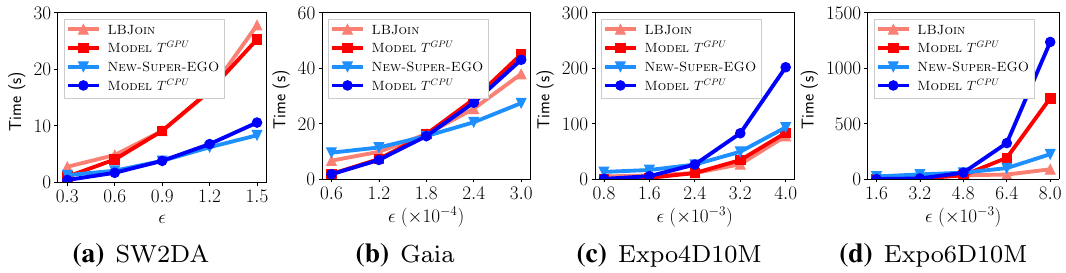
Fig. 8 Comparison of the modeled execution times T GPU and T CPU vs. their corresponding reference execution times LBJ oin and n Ew -S upEr - EGo on a selection of datasets: (a) SW2DA , (b) Gaia , (c) Expo4D10M and (d) Expo6D10M . The results from Platform